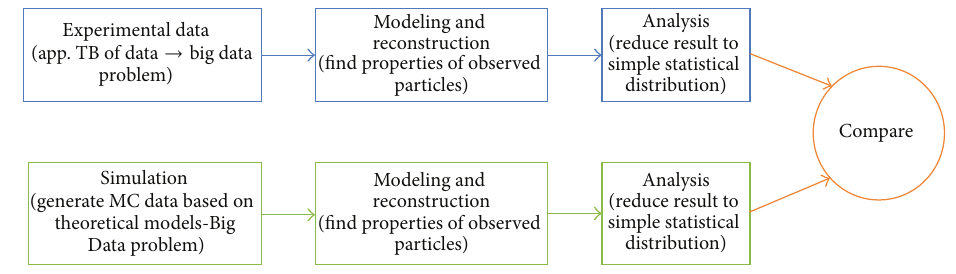
Figure 8: Processing flows for HEP